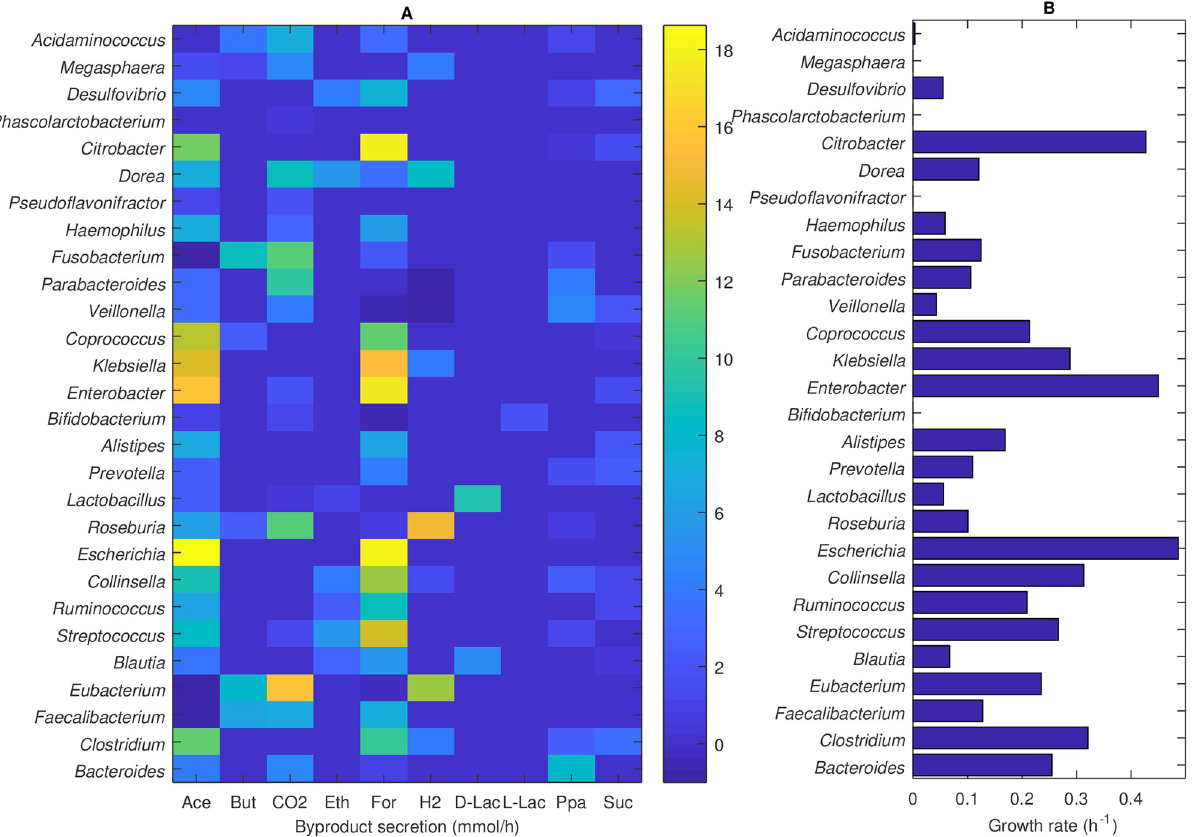
Fig 1. (A) Byproduct synthesis rates and (B) growth rates of the 28 species on an in silico Western diet. The species are listed by their genera. The byproducts listed are acetate (ace), butyrate (but), carbon dioxide (CO 2 ), ethanol (eth), formate (for), hydrogen (H 2 ), D-lactate (D-lac), L-lactate (L-lac). propionate (ppa) and succinate